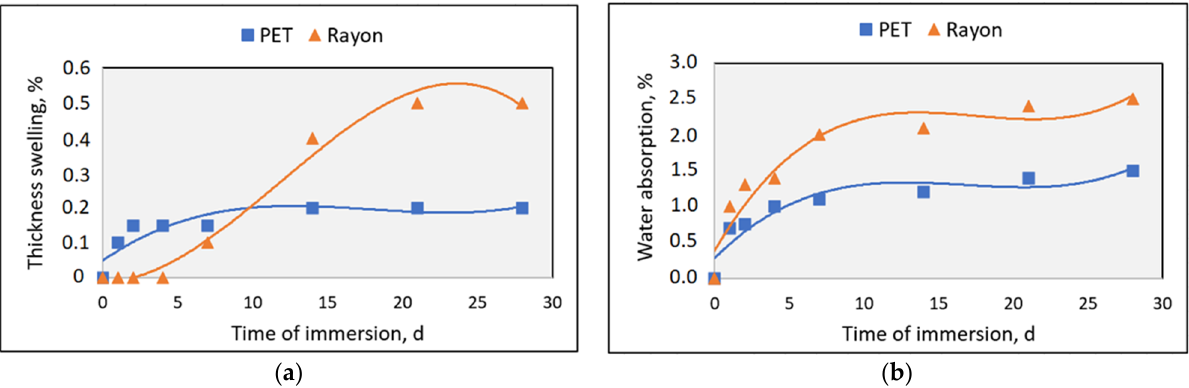
Figure 1. Thickness swelling ( a ) and water absorption ( b ) of the studied materials as a function of immersion time in days. The properties of studies materials are presented as an average of 15 samples.